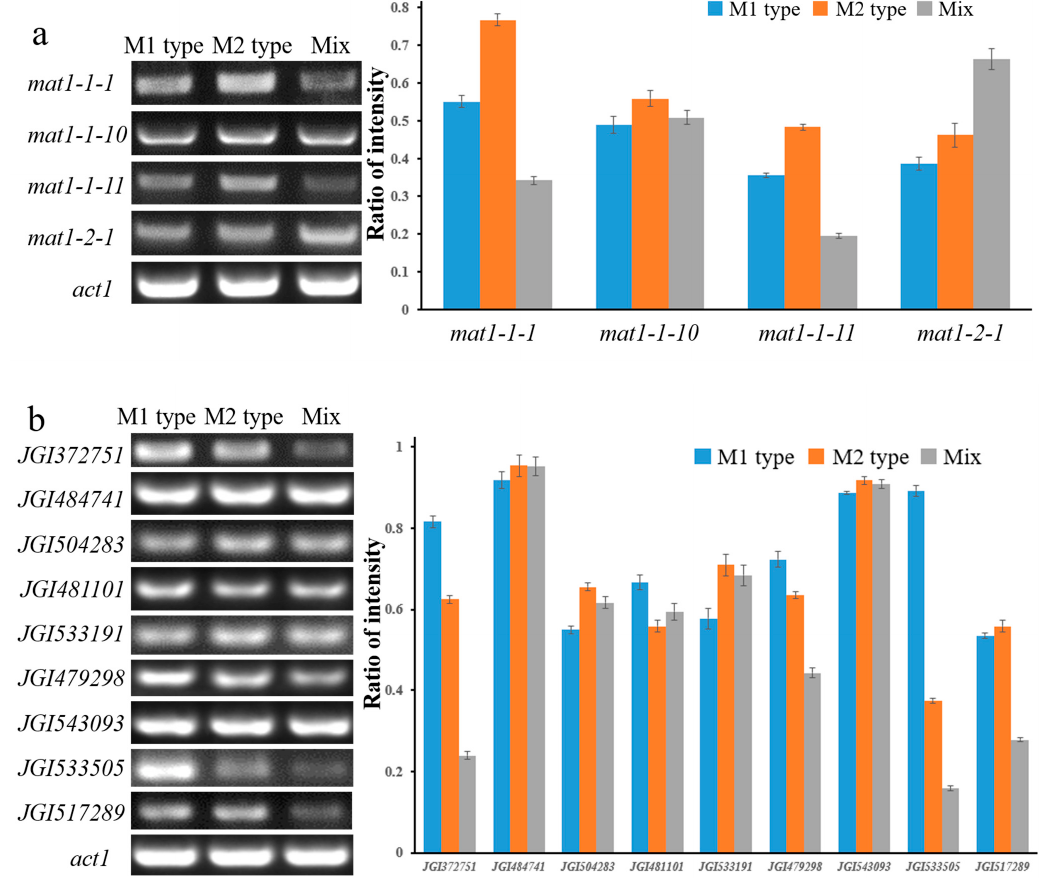
Figure 6. The transcription level of mating-type genes and ascus development-related genes in pileus. ( a ) Expression of mating-type genes detected by reverse-transcription (RT)-PCR in different tissue blocks (Table S4.1). The intensity ratio indicated mating-type gene expression versus act1 expression. ( b ) Reverse transcription (RT)-PCR was performed to detect the expression of genes related to ascus development in different tissue blocks (Table S4.2). Constitutive act1 served as the control. The intensity ratio indicated target gene expression versus act1 expression. Error bars indicate standard